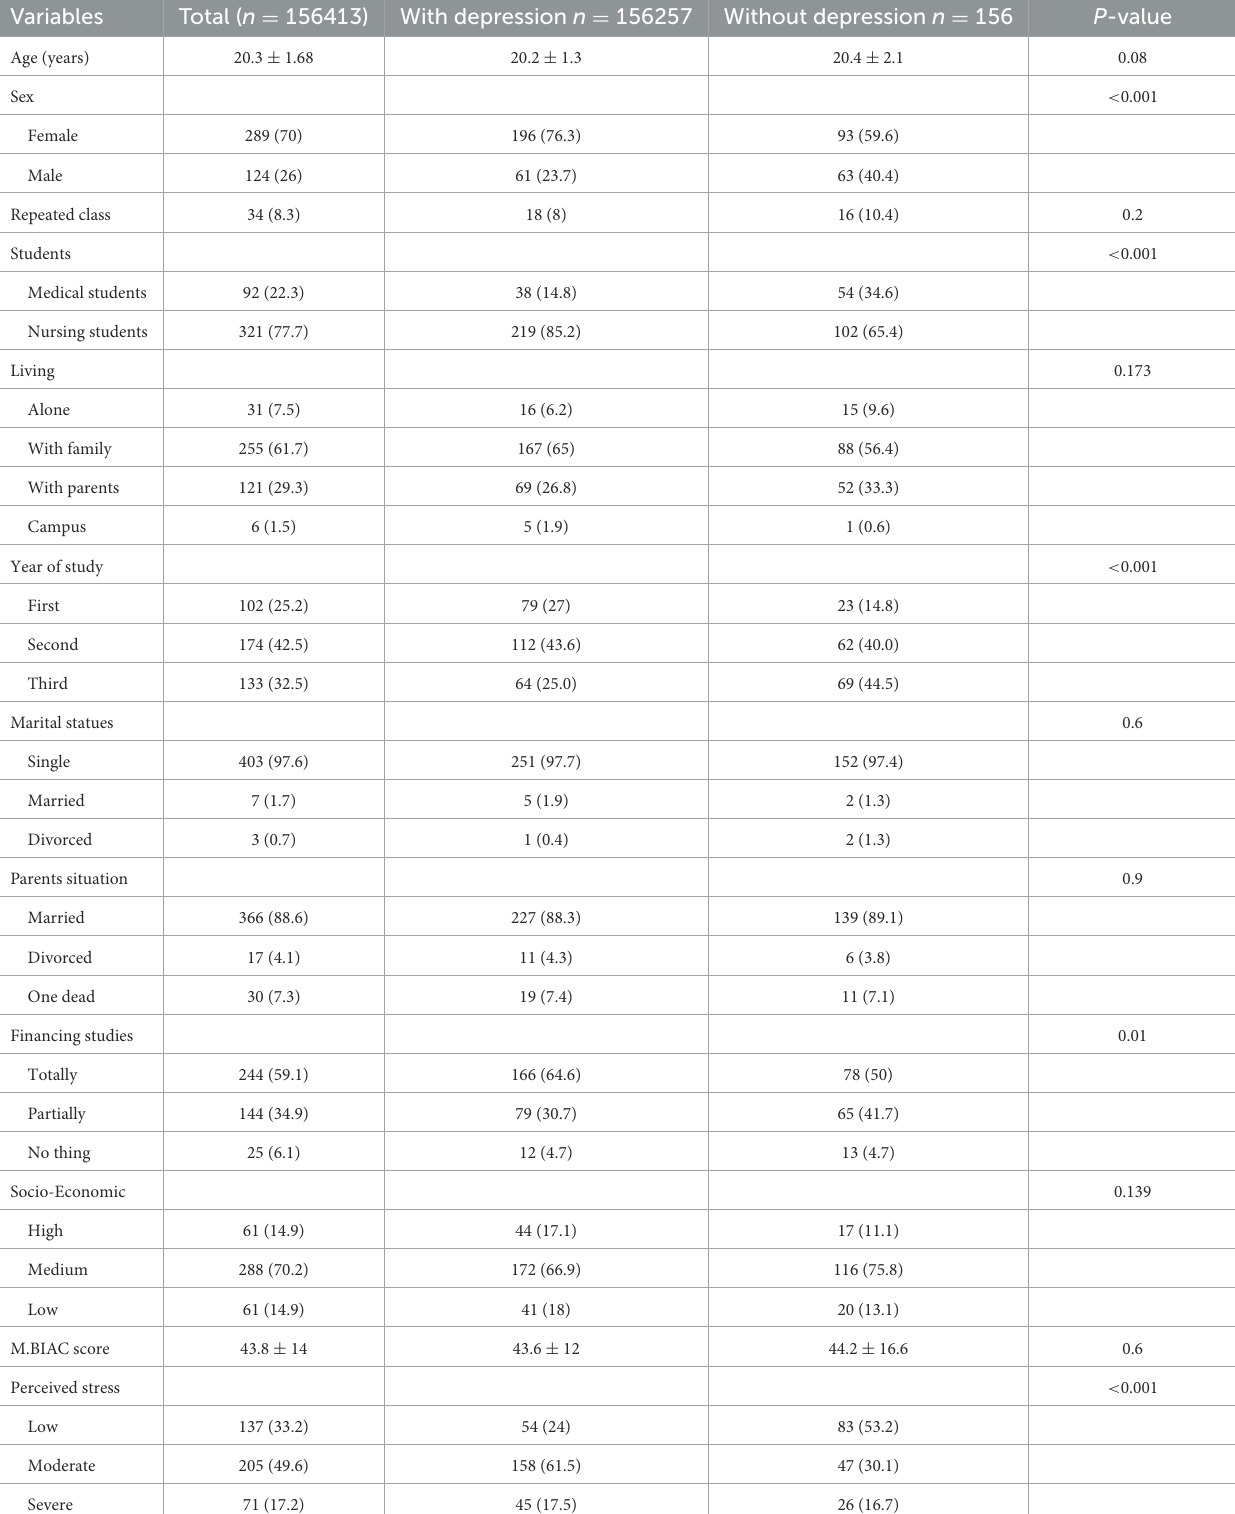
TABLE 1 Comparison of depression with sociodemographic data, religiosity, depression, and stress scores (BIAC). Variables Total ( n = 156413) With depression n =